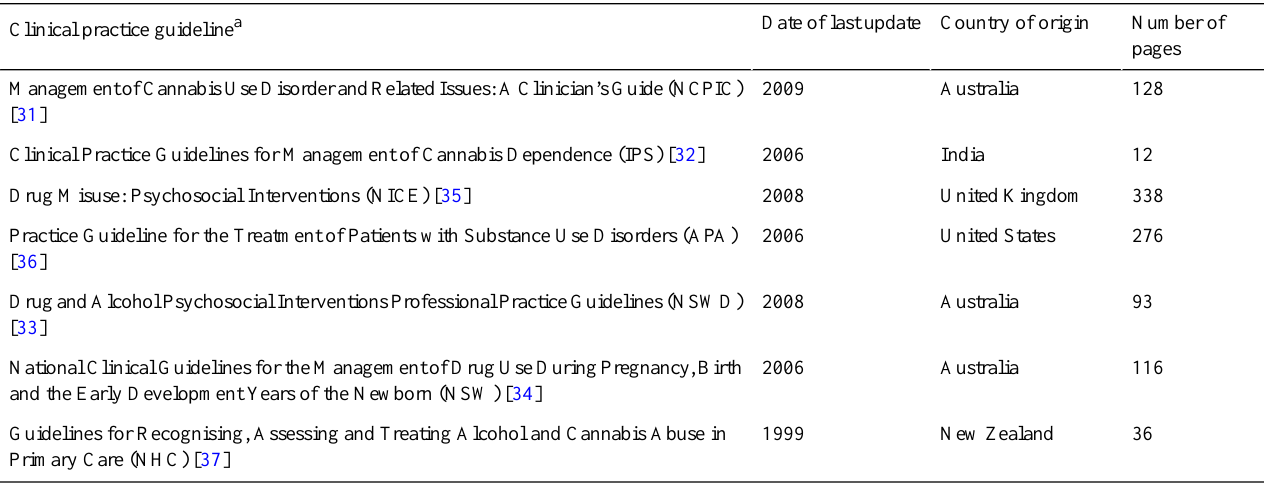
Table 1. Clinical practice guidelines